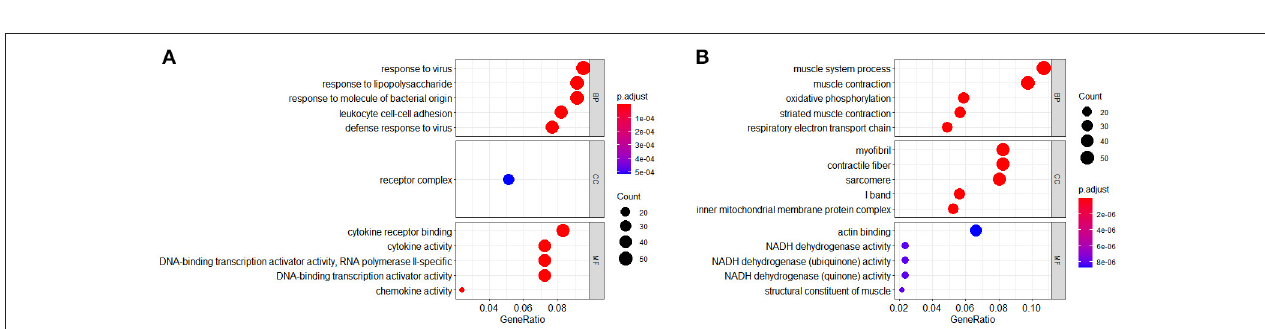
FIGURE 2 | Gene set enrichment analysis (GSEA) of SARS-CoV-2 infection in hiPSC-CMs. (a–i) Nine representative gene sets enriched in hiPSC-CMs with SARS-CoV-2 infection; (j–n) Five representative gene sets inhibited in hiPSC-CMs with SARS-CoV-2 infection; (o) Ranked gene list correlation profile. The red color indicates the “COV” group, the blue color indicates the “MOCK” group, the black line indicates the genes in the GENE SET, and the green line consists of the enrichment fraction of each gene.